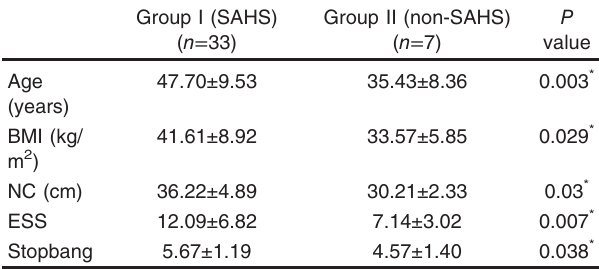
Table 2 Anthropometric parameters and OSA screening questionnaires in the SAHS group versus the non-SAHS group